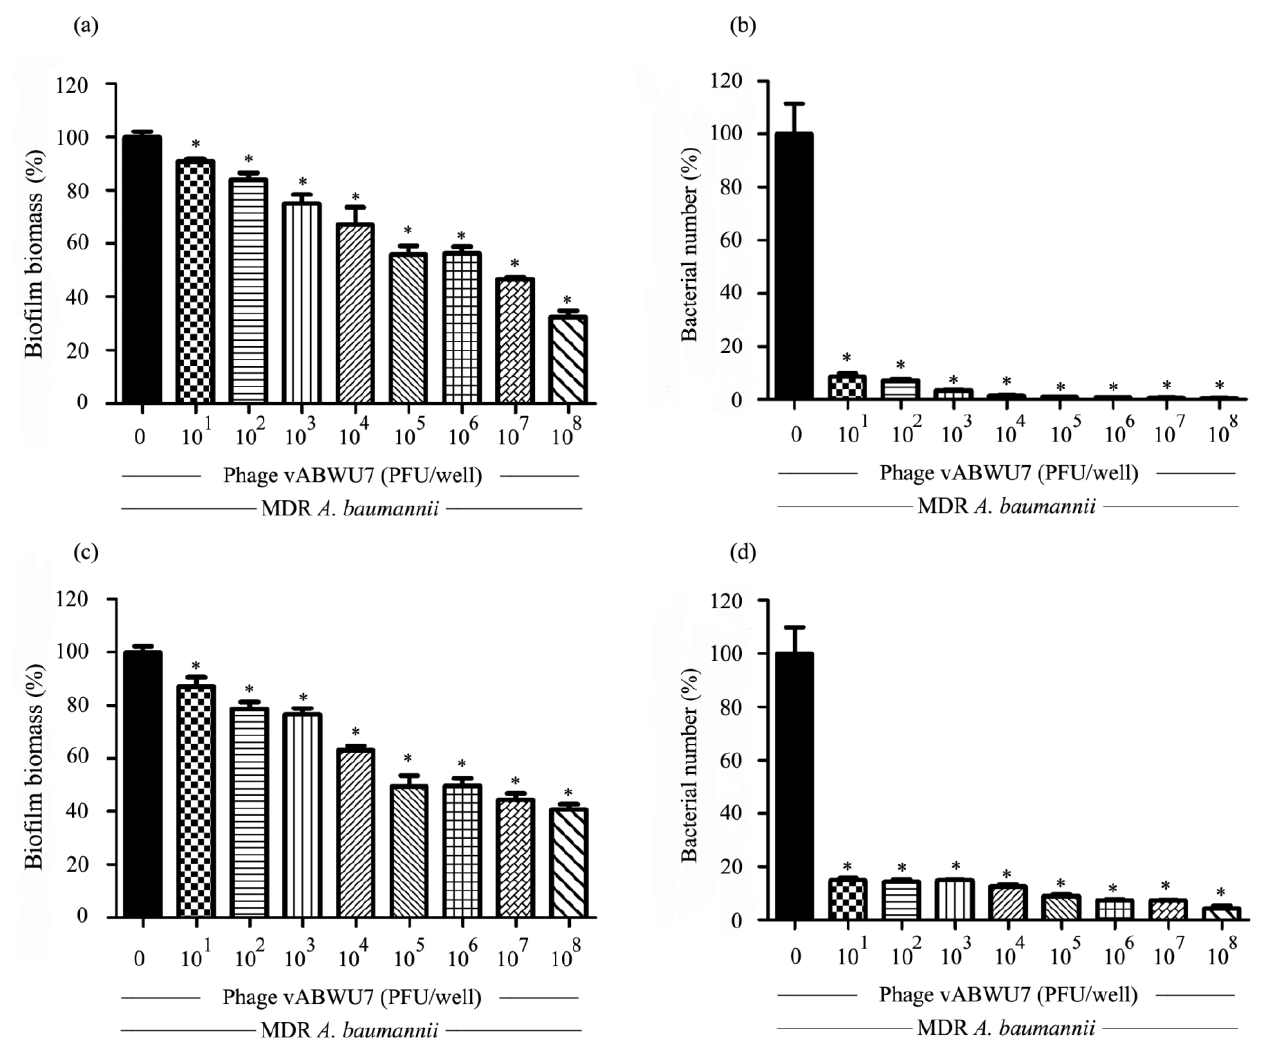
Figure 6. Efficacy of phage vABWU7 to prevent biofilm formation and remove preformed biofilm.